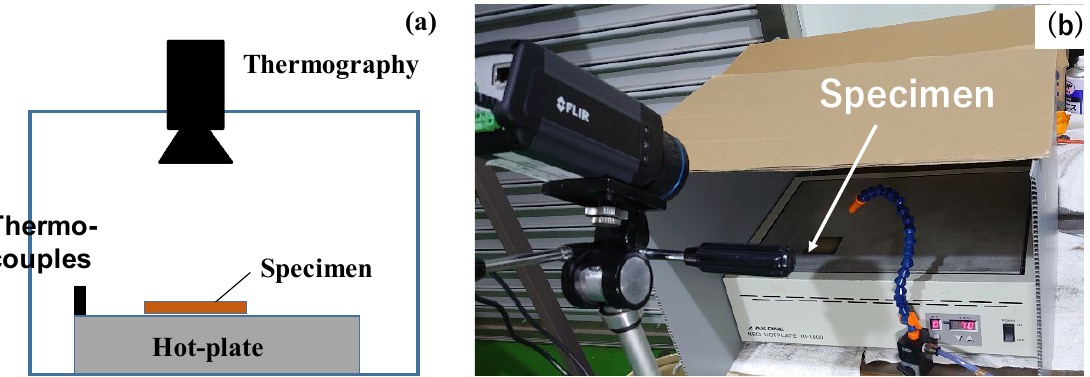
Figure 5. Experimental setup for measurement of the emitter temperature on the acicular micro- textured copper plate. ( a ) Schematic view on the setup and ( b ) overview of the setup.